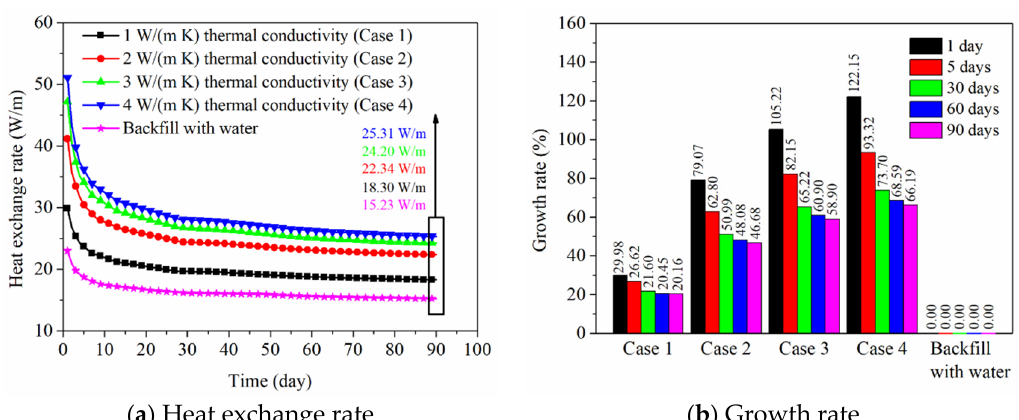
Figure 11. Effect of thermal conductivity of backfill soil in PHC pile on the thermal performance of energy pile.